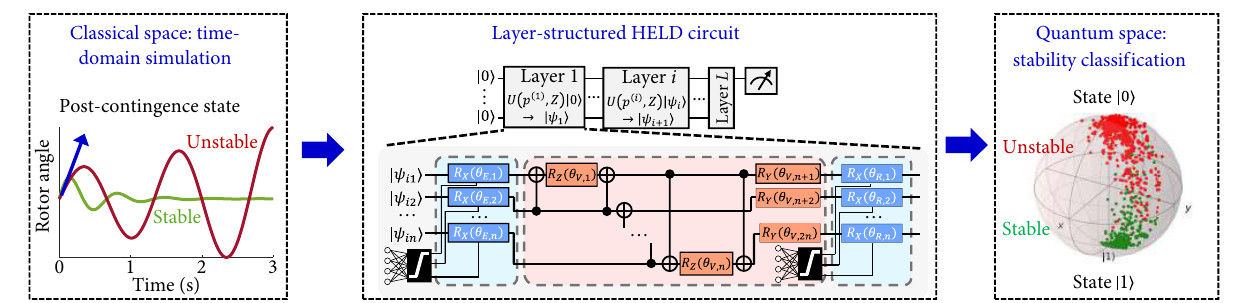
Fig. 6 Schematic of quantum machine learning-enabled power system stability